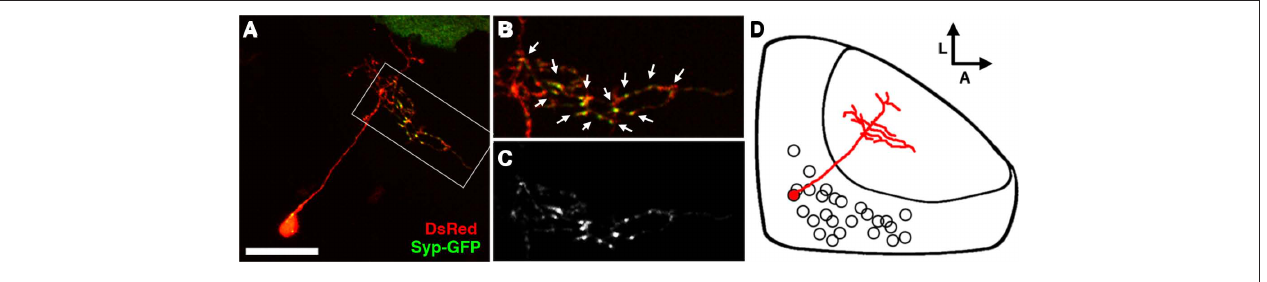
layer (arrows in D ), whereas puncta are absent from the more superficial arbor (arrowheads in C ). (D) Schematic depiction of bsPVIN cell body distribution throughout the SPV layer. Cell traced in red indicates the relative location and scale of neuron depicted in (C) . Scale bar, 20 μm in (A) , 10 μm in (B,C ).